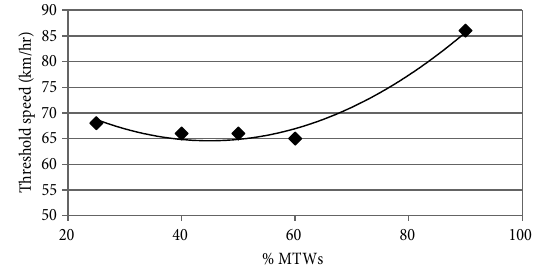
Fig. 7. Variation of density diminishing factor with speed for various proportions of MTWs